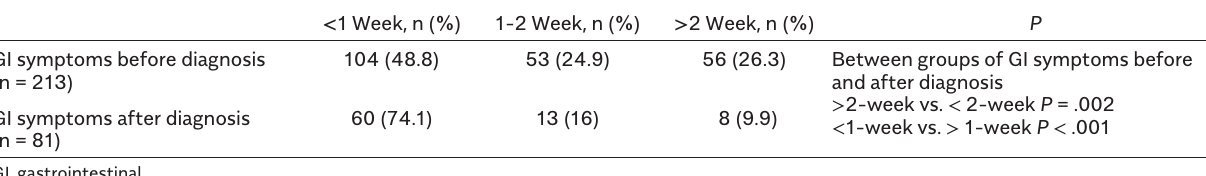
Table 4. The Time of Onset of the GI Symptom and the Duration of the GI Symptom < 1 Week, n (%) 1-2 Week, n (%) > 2 Week, n (%) P GI symptoms before diagnosis (n = 213)